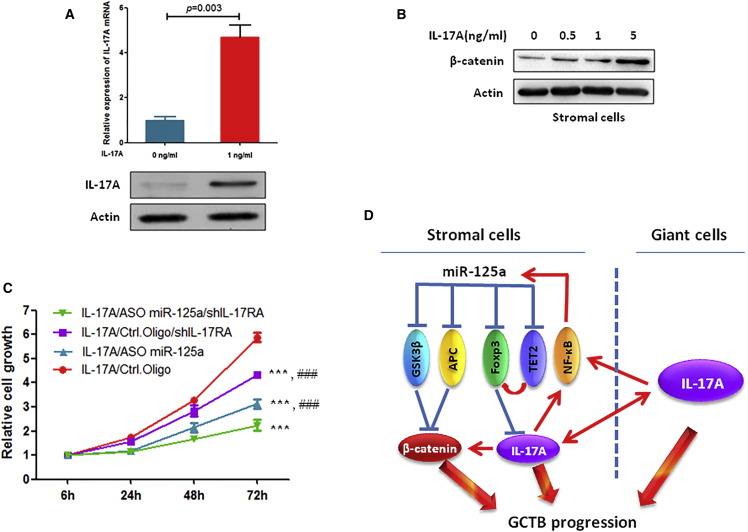
Simultaneously Blocking IL-17A and miR-125a More Strongly Inhibited Stromal Cell Growth(A) IL-17A stimulates IL-17A expression in stromal cells. Stromal cells were treated with 1 ng/mL IL-17A for 24 hr, and the IL-17A expression in stromal cells was measured using qRT-PCR and western blot. (B) IL-17A stimulates β-catenin expression in stromal cells. Stromal cells were treated with the indicated concentration of IL-17A for 24 hr and then subjected to western blot analysis. (C) Stromal cells were transfected with the indicated nucleotides and/or lentiviral vectors and treated with 1 ng/mL IL-17A, and then cell viability was measured at the indicated times. Ctrl. Oligo, control oligonucleotides; ###p < 0.001 (compared to IL-17A/ASO miR-125a/shIL-17RA group); ***p < 0.001 (compared to IL-17A/Ctrl. Oligo group). (D) A schematic model of the regulation of GCTB progression by miR-125a and IL-17A.